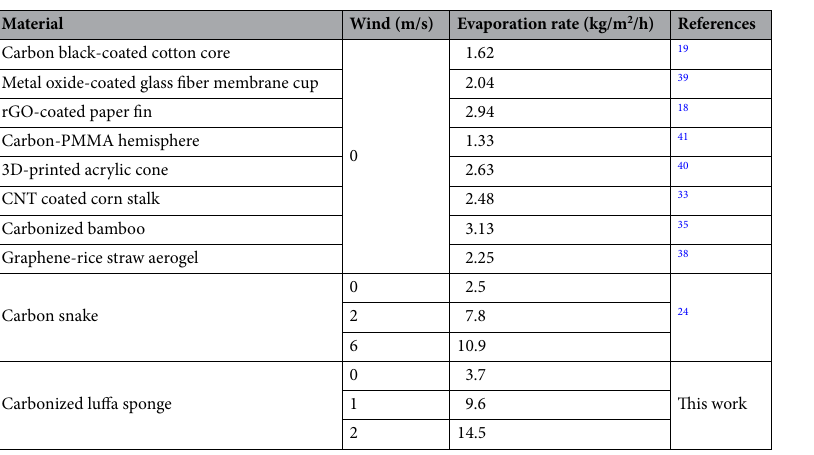
Table 1. Evaporation rates of water using various 3D